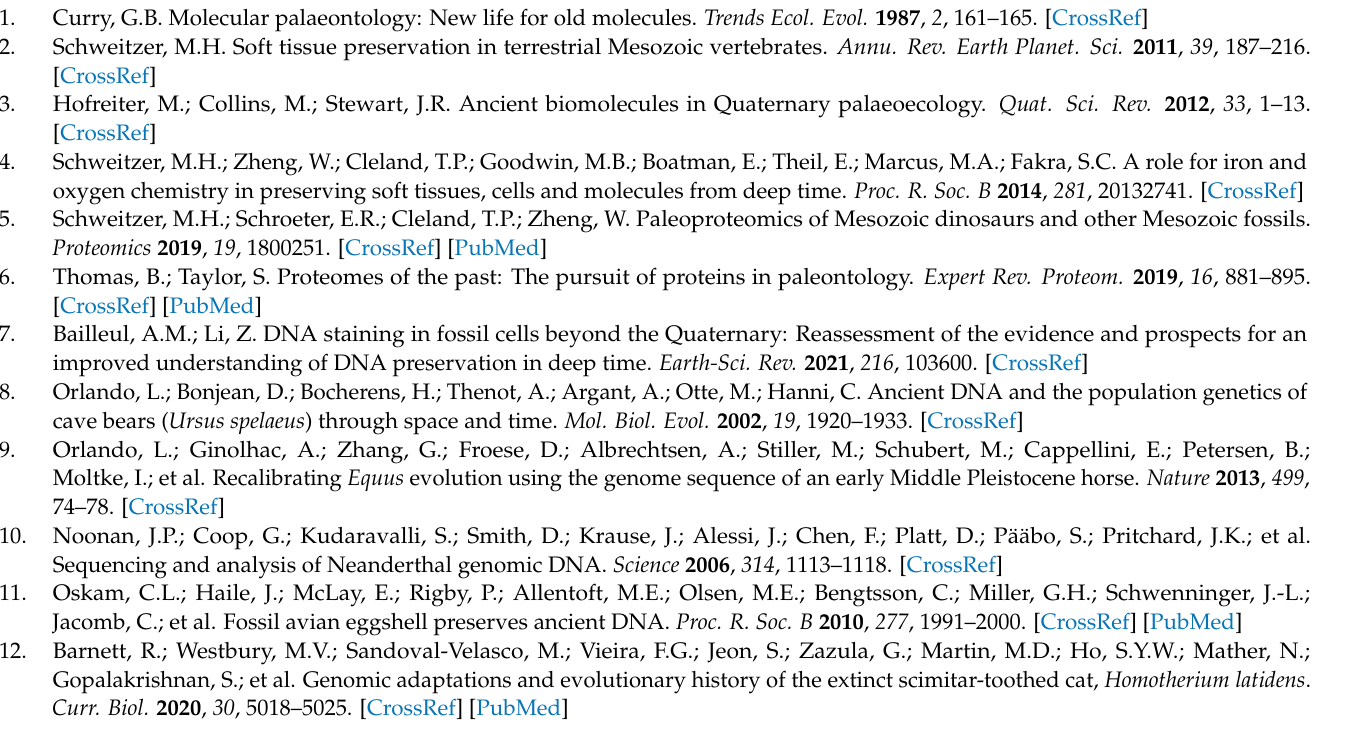
S1–S3. Figure S1: Complete stratigraphic section across the entire butte from which MOR 1125 was collected. Figure S2: Intra-bone patterns of (Ce/Ce*) N , (Ce/Ce**) N , and (La/La*) N anomalies and Y/Ho ratios within the femur of MOR 1125. Figure S3: Cerium anomaly (Ce/Ce**) N values plotted against uranium (U) concentrations in the femur of MOR 1125. Data S1: Raw transect data acquired and analyzed in this study, provided as an XLSX Excel